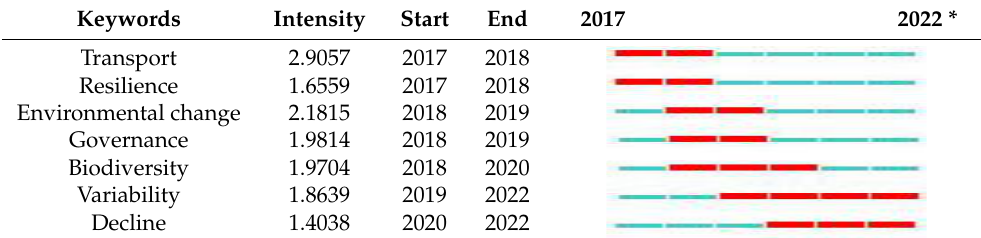
Table 4. Burst keywords highlighting intensity and timing of RCHSCC in 2017–2022.